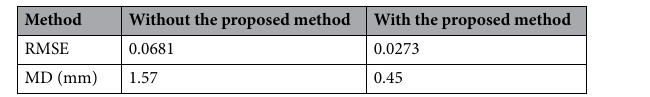
Table 4. Quantitative comparisons of the metal product 2 (RMSE and MD).